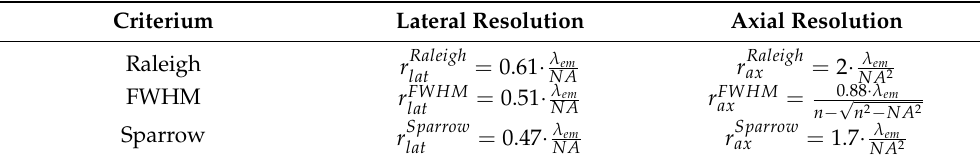
Table 4. Resolution criteria and obtainable resolutions for fluorescence wide-field imaging. Criterium Lateral Resolution Axial Resolution Raleigh r Raleigh = 0.61 · λ em NA lat Sparrow